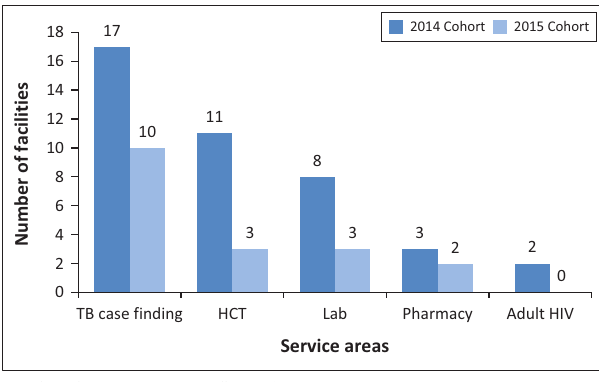
FIGURE 1: Number of healthcare facilities with red-flagged service areas following the 2014 and 2015 audits.